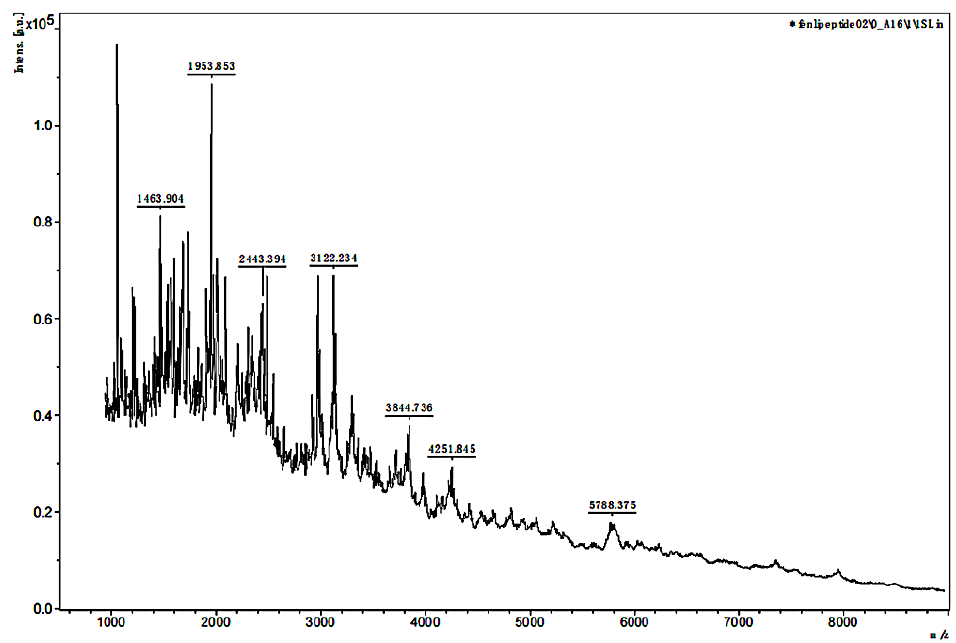
Figure 4. MALDI-TOF MS mass spectra of sample 2.